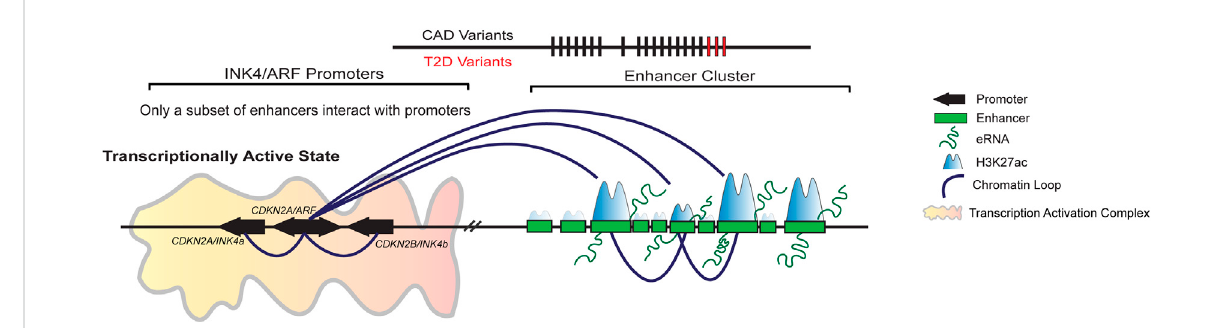
FIGURE 4 A subset of enhancers in the enhancer cluster upstream regulates INK4/ARF locus. Gene desert upstream of INK4/ARF genes contains 21 enhancers in HeLa cells. Only 15 of these enhancers are active, displaying both H3K27ac and H3K4me1 marks. Out of 15 active enhancers, only a subset of enhancers interacts with the promoters of INK4/ARF genes. The promoter interacting enhancers are critical for the regulation of these genes. The deletion of a single enhancer causes down regulation of gene transcription and EZH2 loading on the promoters. Furthermore, the deletion of interacting enhancers has an effect on the other enhancers in the cluster, indicating that the enhancers are